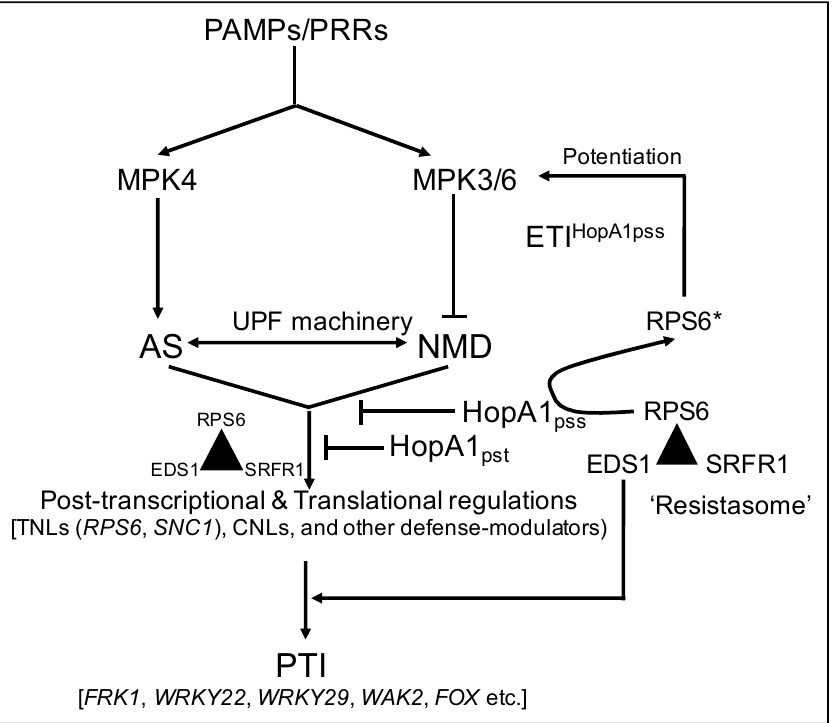
Figure 7. Schematic hypothetical model of HopA1 virulence, elicitation of ETI HopA1pss and poten- tiation on PTI. PAMP perceptions by PRRs elicit PTI utilizing the MAPK (MPK3/4/6) networks to perturb AS-NMD pathway through the degradation of UPF proteins, phosphorylation of splic- ing and other associated factors. Upregulated splice variants of TNL s (RPS6, SNC1) and other defense-associated transcripts contribute to PTI signaling. Defensive overshoots are prevented